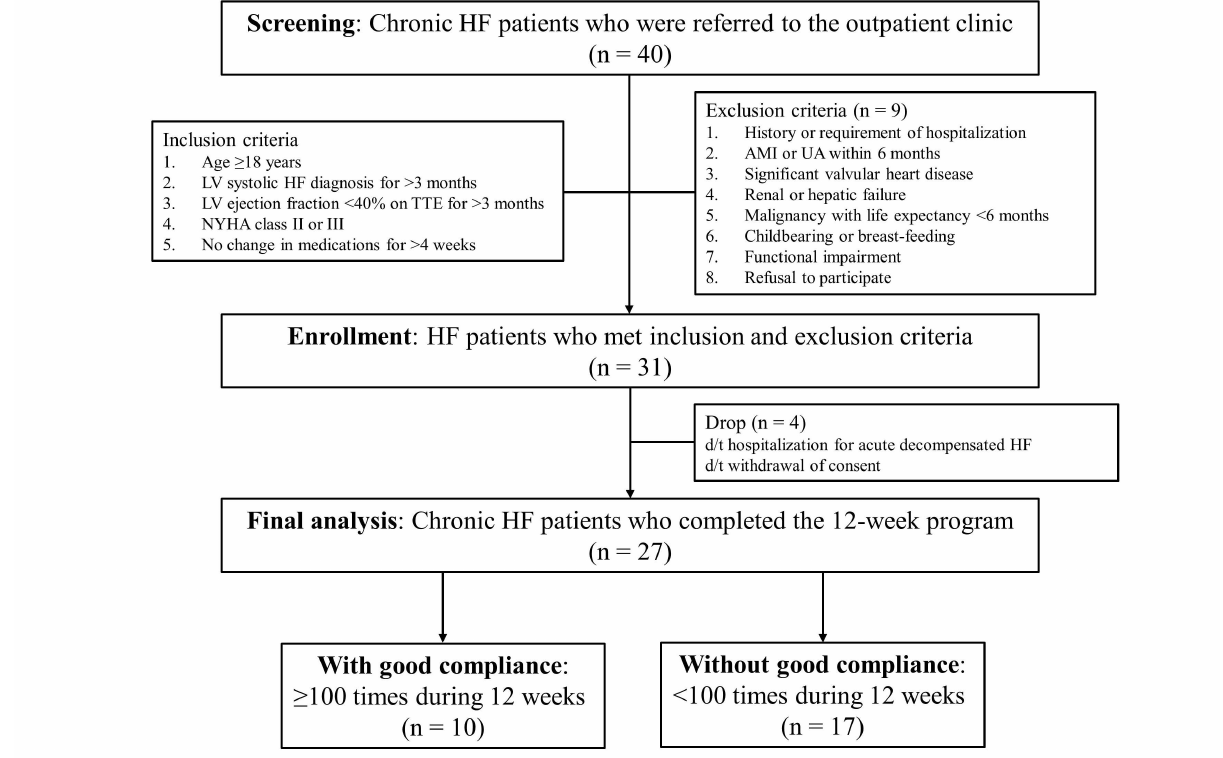
Figure 1. Study flow of ICT-based telehealth program in HF. ICT: information communication technology. HF: heart failure, LV: left